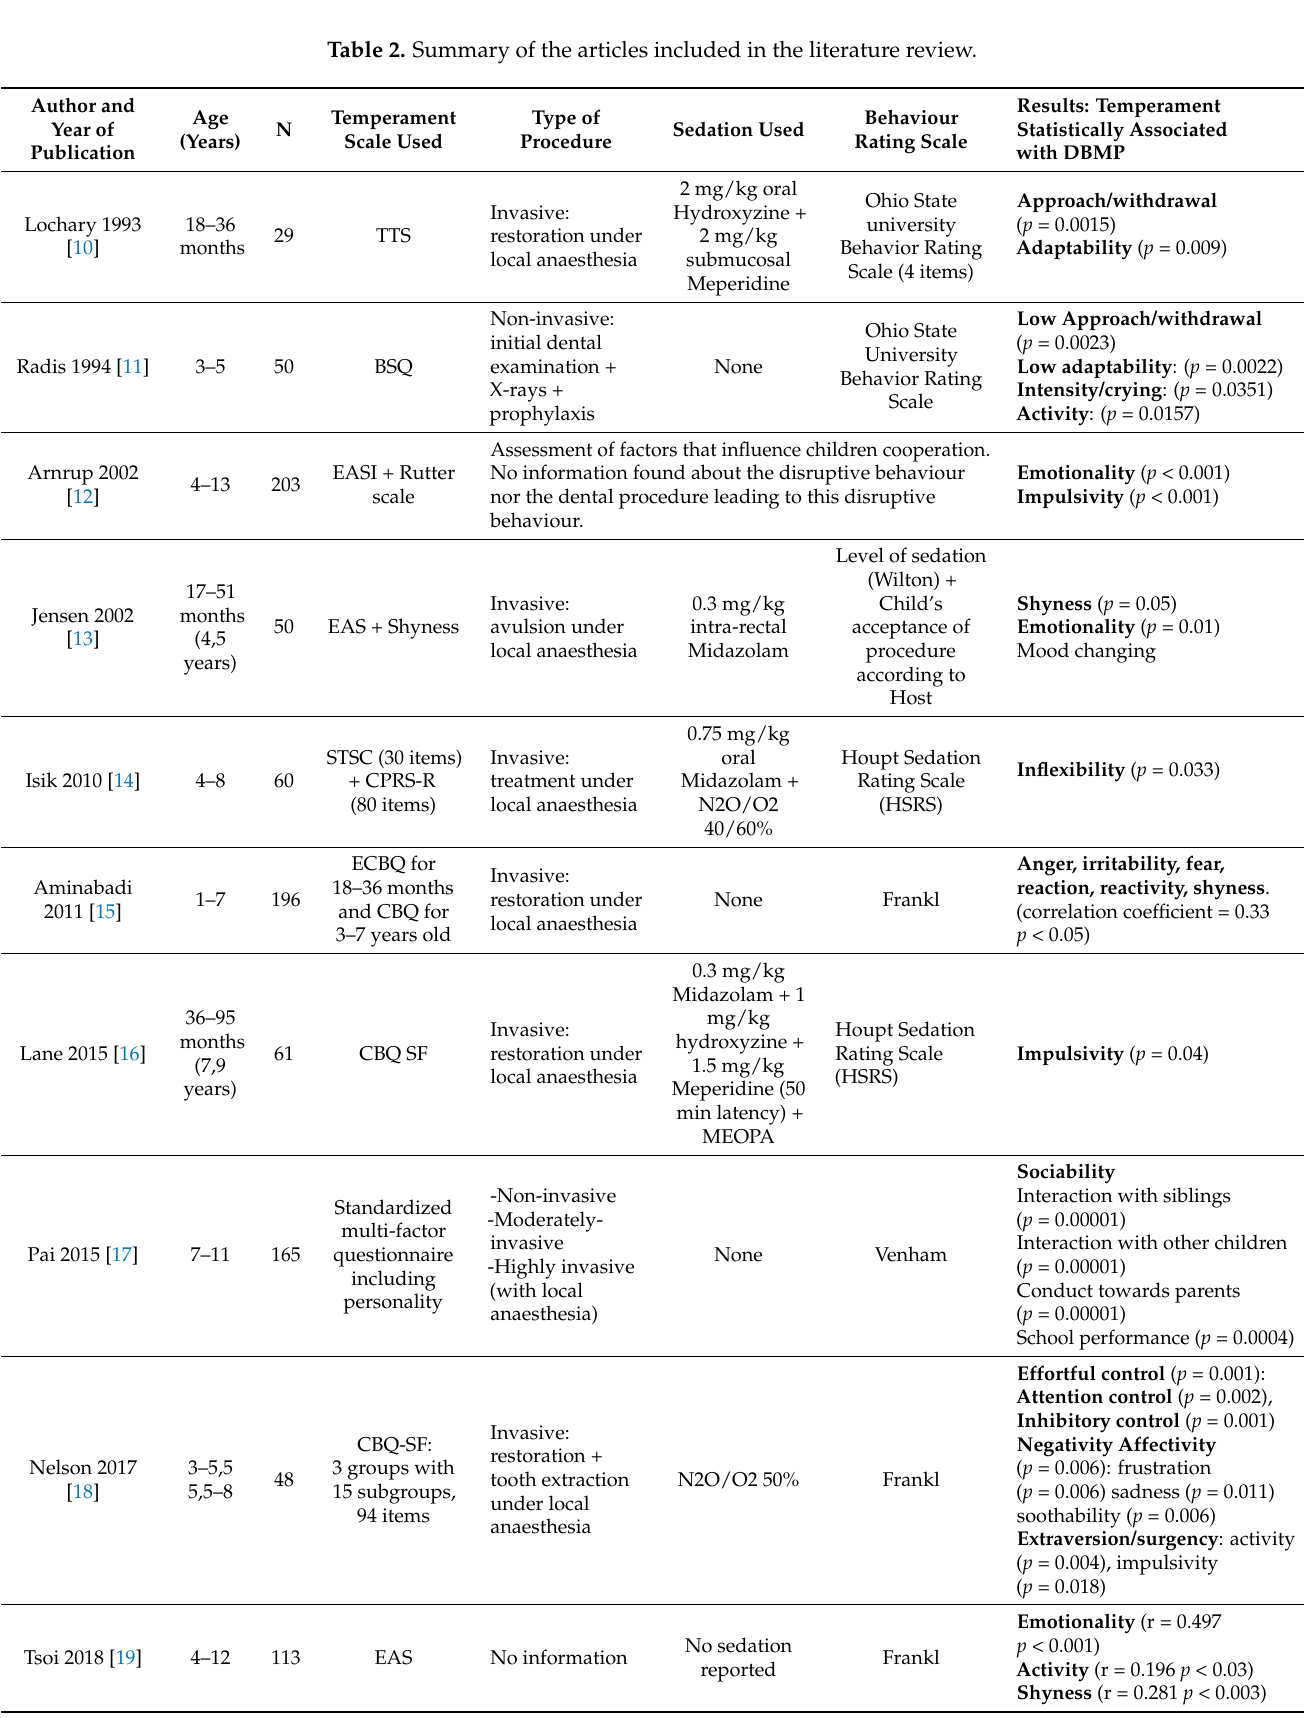
Table 2. Summary of the articles included in the literature